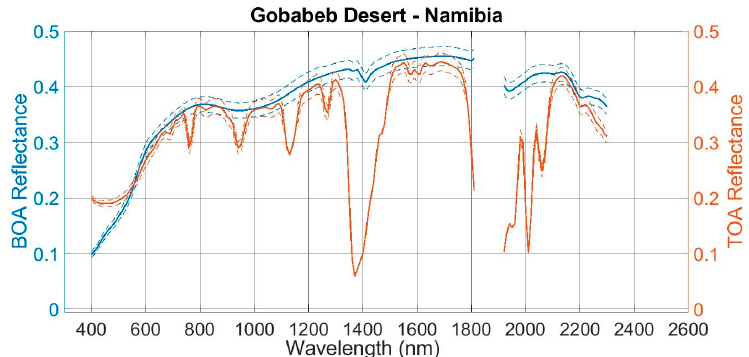
Figure 8. In the y -axis left and right side of the graph is presented, respectively, the BOA and TOA reflectance of the Gobabeb (GONA) measured in situ on 10 October 2019.